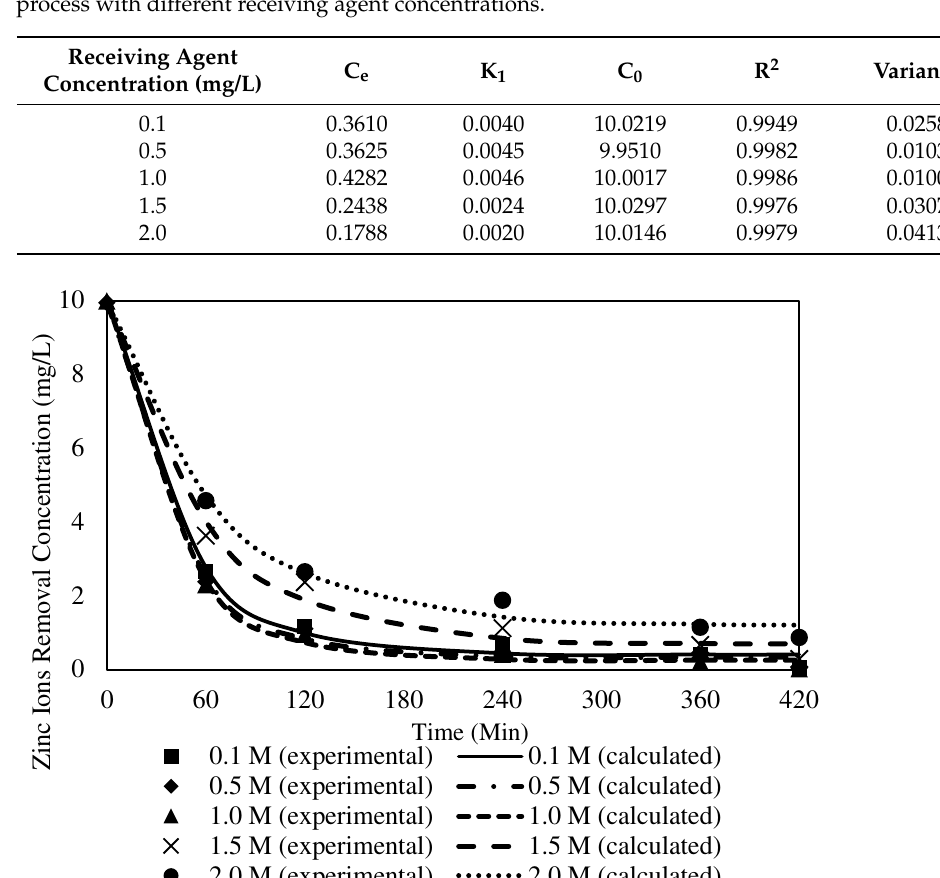
Figure 18. Fitting of the experimental data to the PFO model describing Zn 2+ removal with the W3 membrane over time at different receiving agent concentrations.